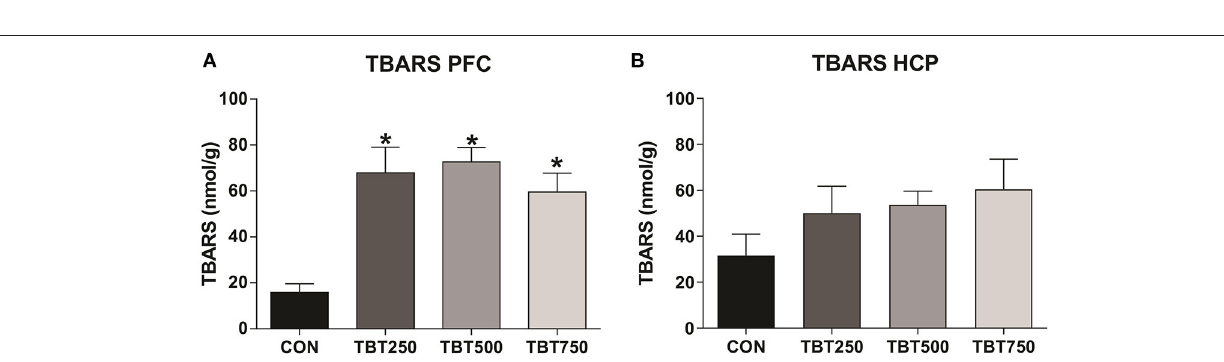
FIGURE 3 | TBT exposure increases oxidative stress in brain areas of female mice. Increased PFC (A) and hippocampus (HCP) (B) TBARS levels. * p < 0.05 vs. CON (one-way ANOVA, followed by Bonferroni’s test).